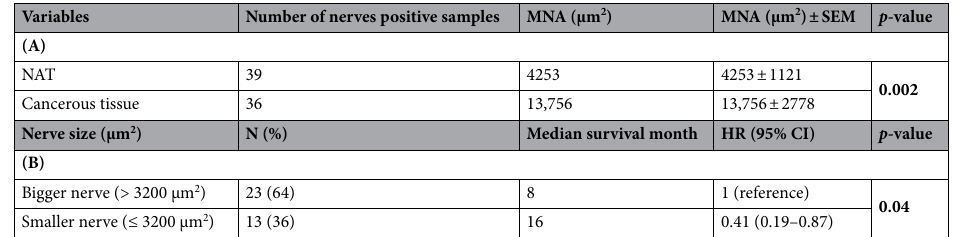
Table 4. (A) Comparison of nerve related parameters in PC tissue and normal adjacent tissue. Unpaired t-test was performed to compare nerve related parameters in the different groups. Data are represented as mean ± SEM. (B) Correlation between increased nerve size and patient survival. P -values were calculated by the log-rank test. HR was calculated using univariate Mantel–Haenszel hazard model. Values in bold indicate p < 0.05. PC pancreatic cancer, NAT normal adjacent tissue, MNA mean nerve area (μm 2 ), SEM standard error of mean, HR hazard ratio, CI confidence